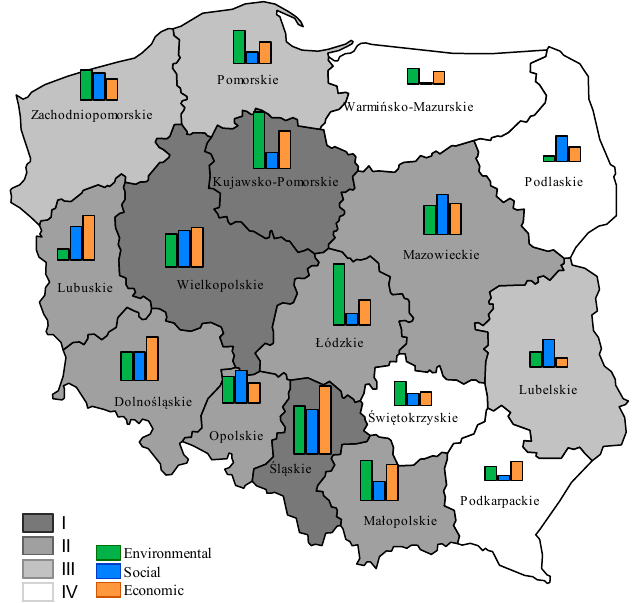
Figure 1. Diversification of sustainable transport development in particular voivodeships according to the classical measure. Note: the background of the voivodeships—the integrated order (total measure), the height of the histogram—denotes the values of the synthetic measures for particular orders i.e., environmental, social, economic. Source: own studies.